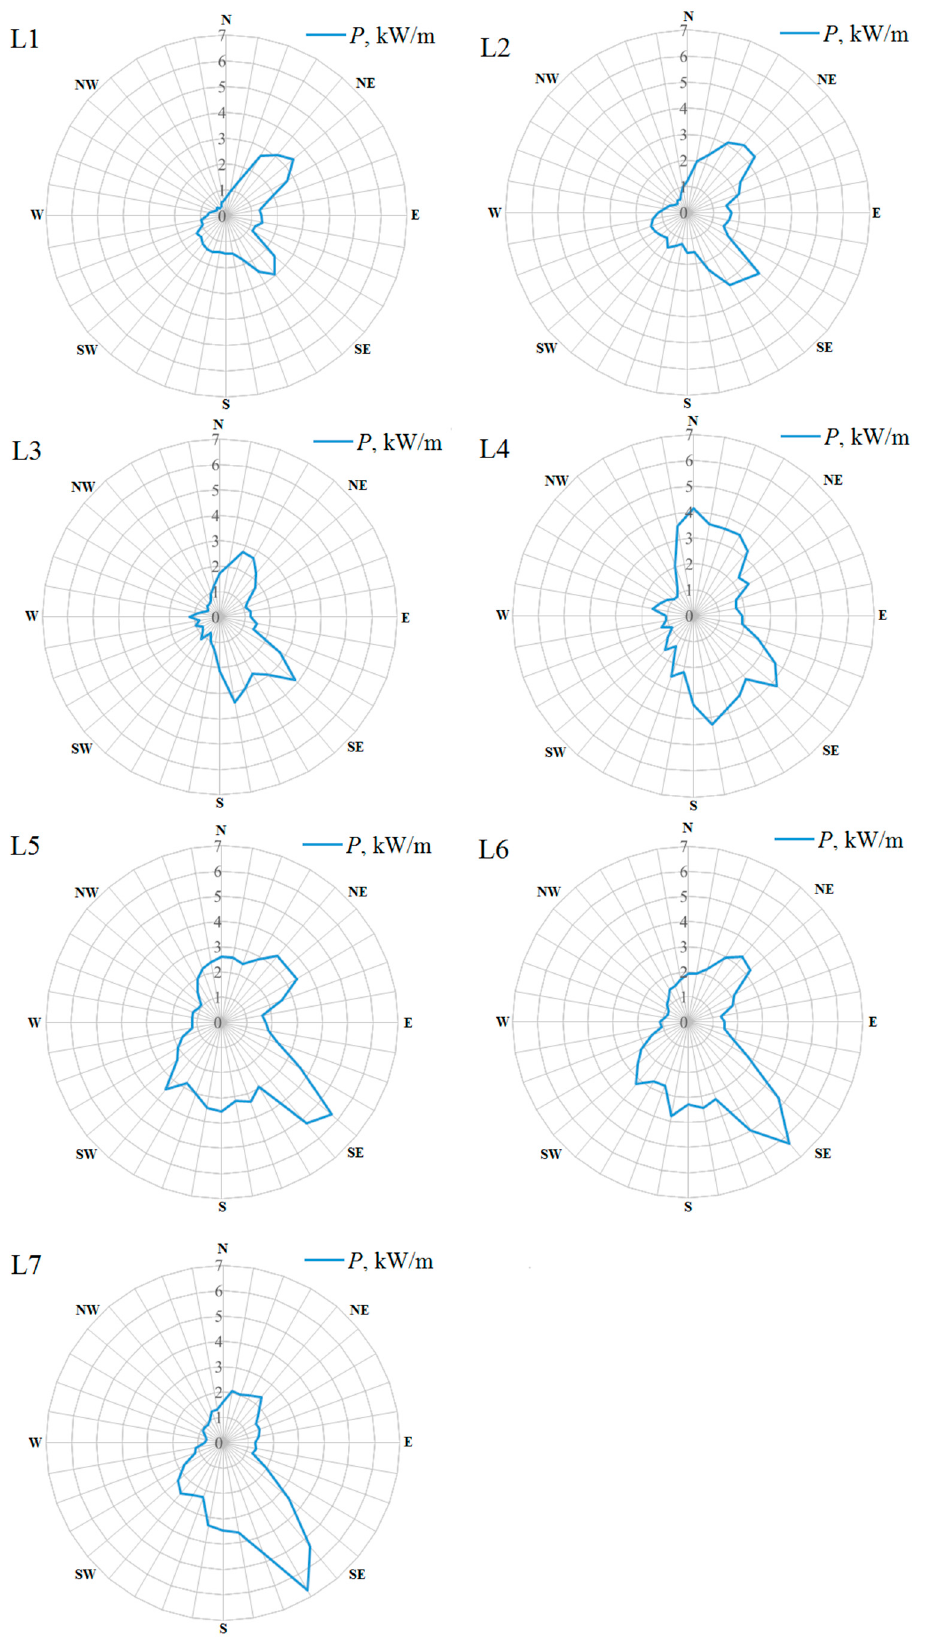
Figure 5. Wave roses for wave power at investigated locations.